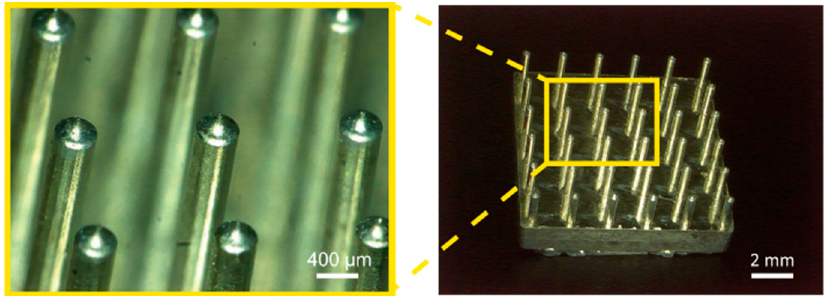
Figure 1. Images of developed CMEs. The pillar structures automatically avoid hair and the sharp tips penetrate the high-impedance stratum corneum. tips penetrate the high-impedance stratum